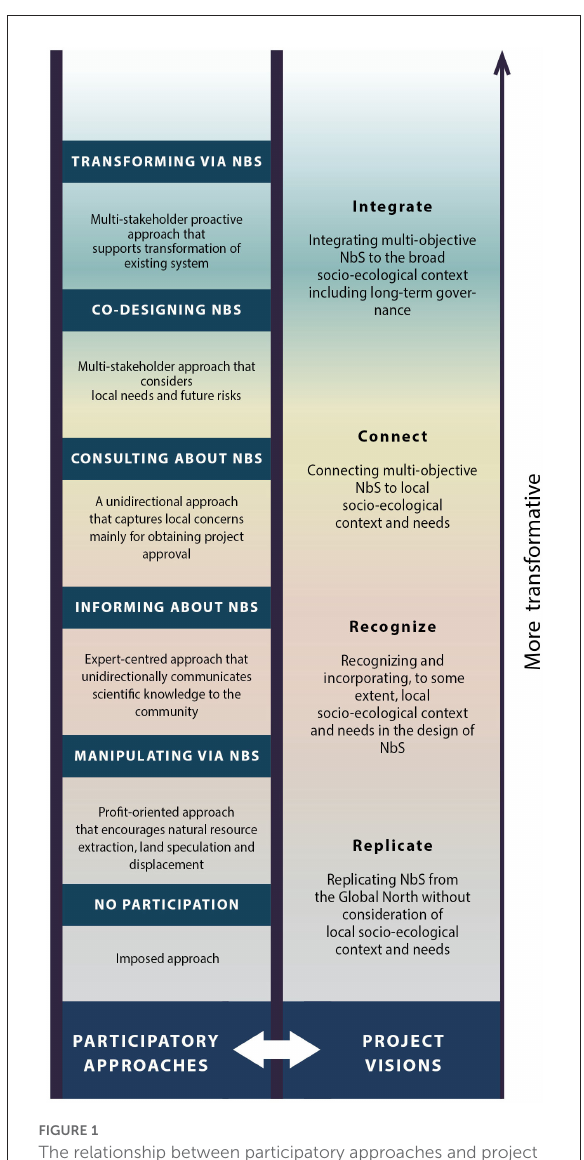
FIGURE1 The relationship between participatory approaches and project visions for the implementation of NbS in the context of informal settlements.